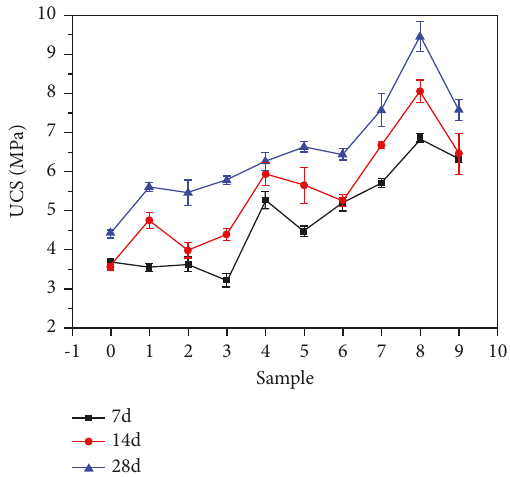
Figure 4: UCS of bio-carbonated RMC-based WDC